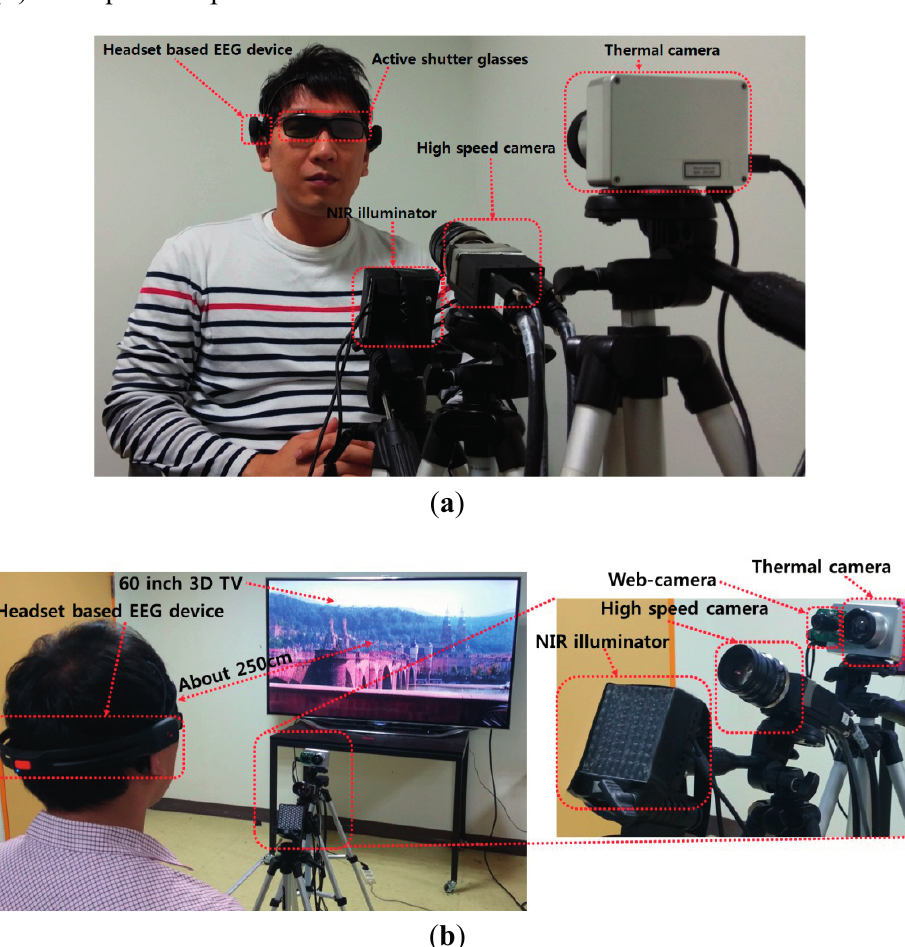
Figure 2. Proposed system for the assessment of eye fatigue. ( a ) Proposed experimental device; ( b ) Example of experimental environment.